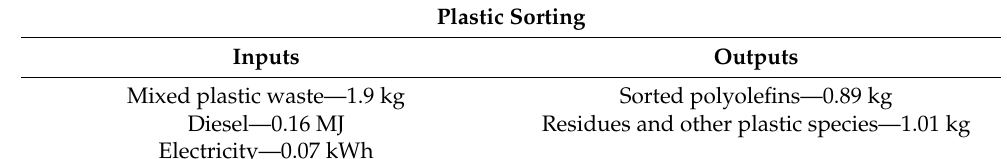
Table 3. Input and output data for the recycling